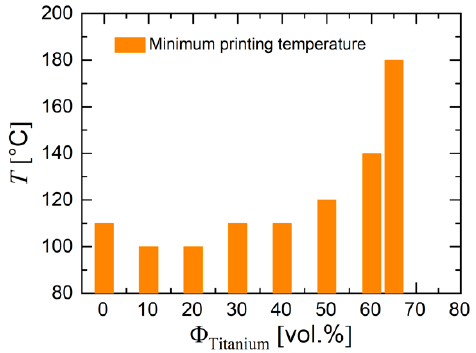
Materials 2020 , 13 , x FOR PEER REVIEW Figure 12. Influence of powder concentration on minimum printing temperature. Figure 12. Influence of powder concentration on minimum printing temperature.